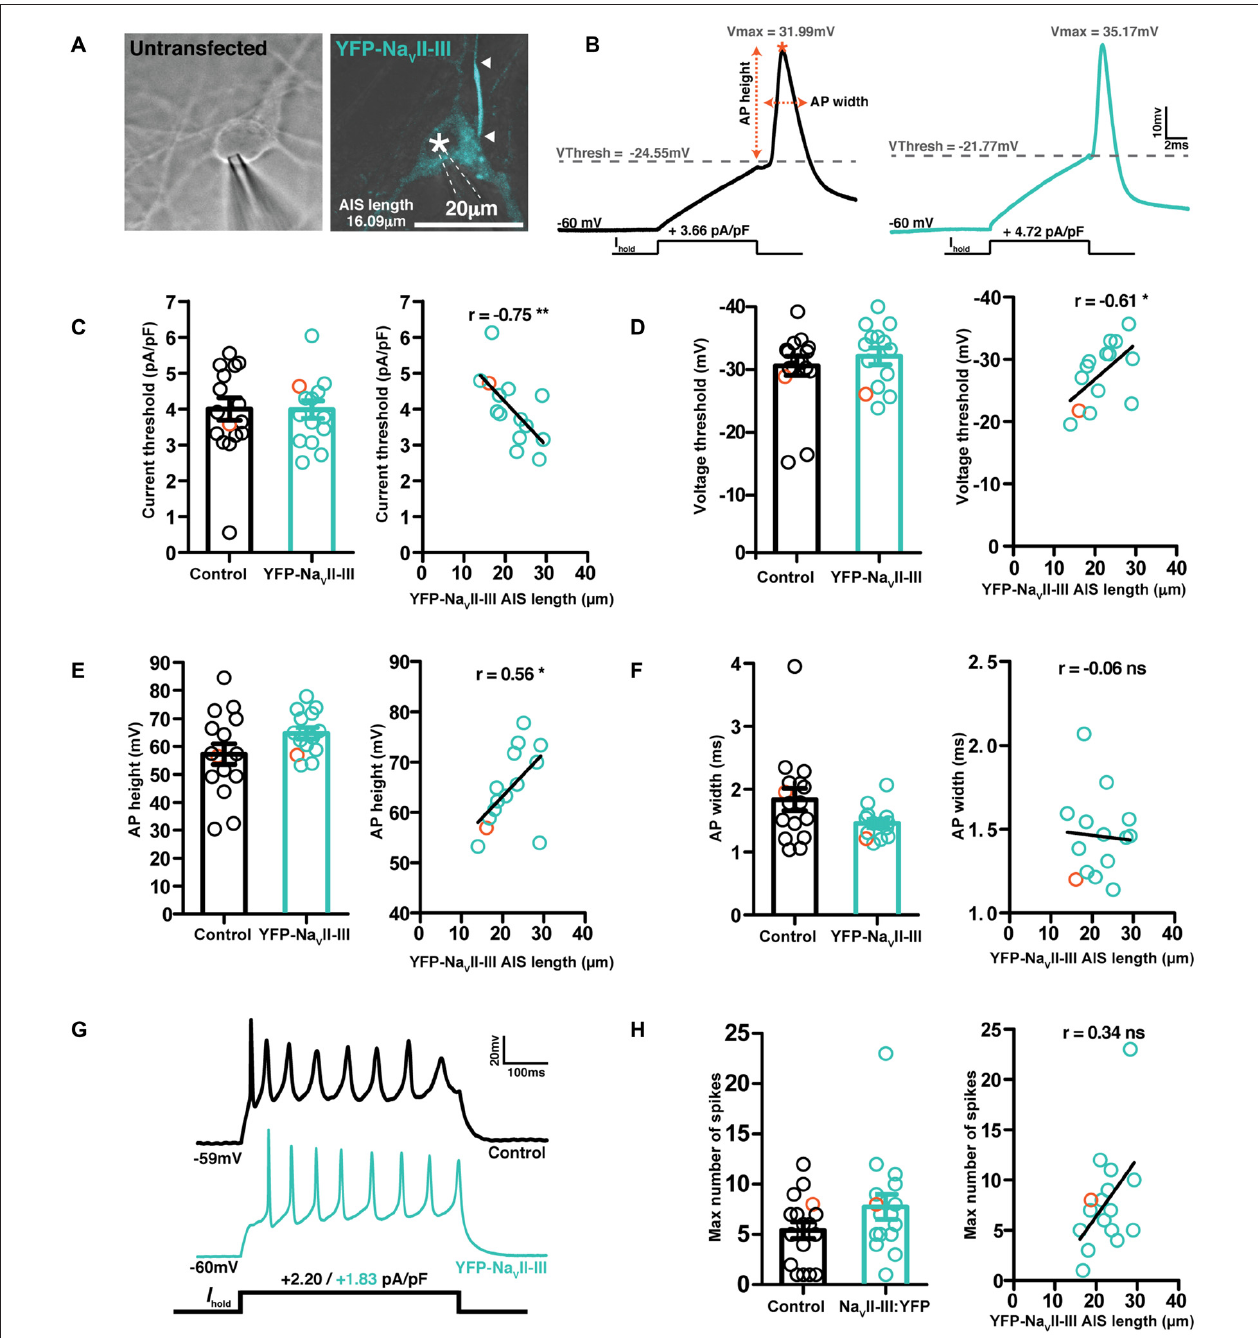
FIGURE 8 | YFP-Na V II–III labeled cells exhibit normal spike firing properties. (A) Brightfield image of a control untransfected neuron, and a maximum intensity projection of a cell expressing YFP-Na V II–III (cyan), both patched in whole-cell mode. Asterisks, nucleus; arrowheads, DGC AIS start and end positions. (B) Example whole-cell current-clamp recordings of threshold APs fired to 10-ms somatic current injection from neurons displayed in (A) ; orange asterisk, V max; orange dotted lines, AP height and width calculation. (C) Single action potential current threshold; left, each dot represents a single cell from either the control untransfected group (black) or YFP-Na V II–III expressing (cyan) group; orange colored symbols represent values from the example cells presented in panel (A) ; bars show mean ± SEM; unpaired t -test p = 0.76. Right, correlation of current threshold vs. AIS length revealed by live label with YFP-Na V II-III; each dot shows one cell; orange dot shows the example cell from panel (A) ; line shows best fit linear regression; ∗∗ p < 0.01. (D) Single action potential voltage threshold; details same as panel (C) ; left, p = 0.37; right, ∗ p < 0.05. (E) Action potential height; details same as panel (C) ; left, p = 0.1; right, ∗ p < 0.05. (F) Action potential width at half height; details same as panel (C) ; left, p = 0.1; right, ns, non-significant. (G) Example traces of maximum firing elicited via a 500 ms duration current injection used to probe repetitive spiking. (H) Maximum number of spikes fired to a 500 ms current injection pulse; details same as panel (C) ; left, p = 0.2; right, ns, non-significant.